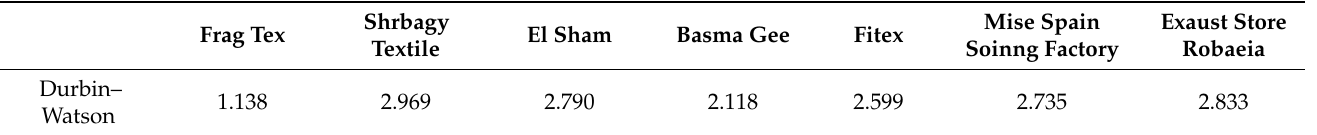
Table 9. Durbin–Watson autocorrelation for the seven case